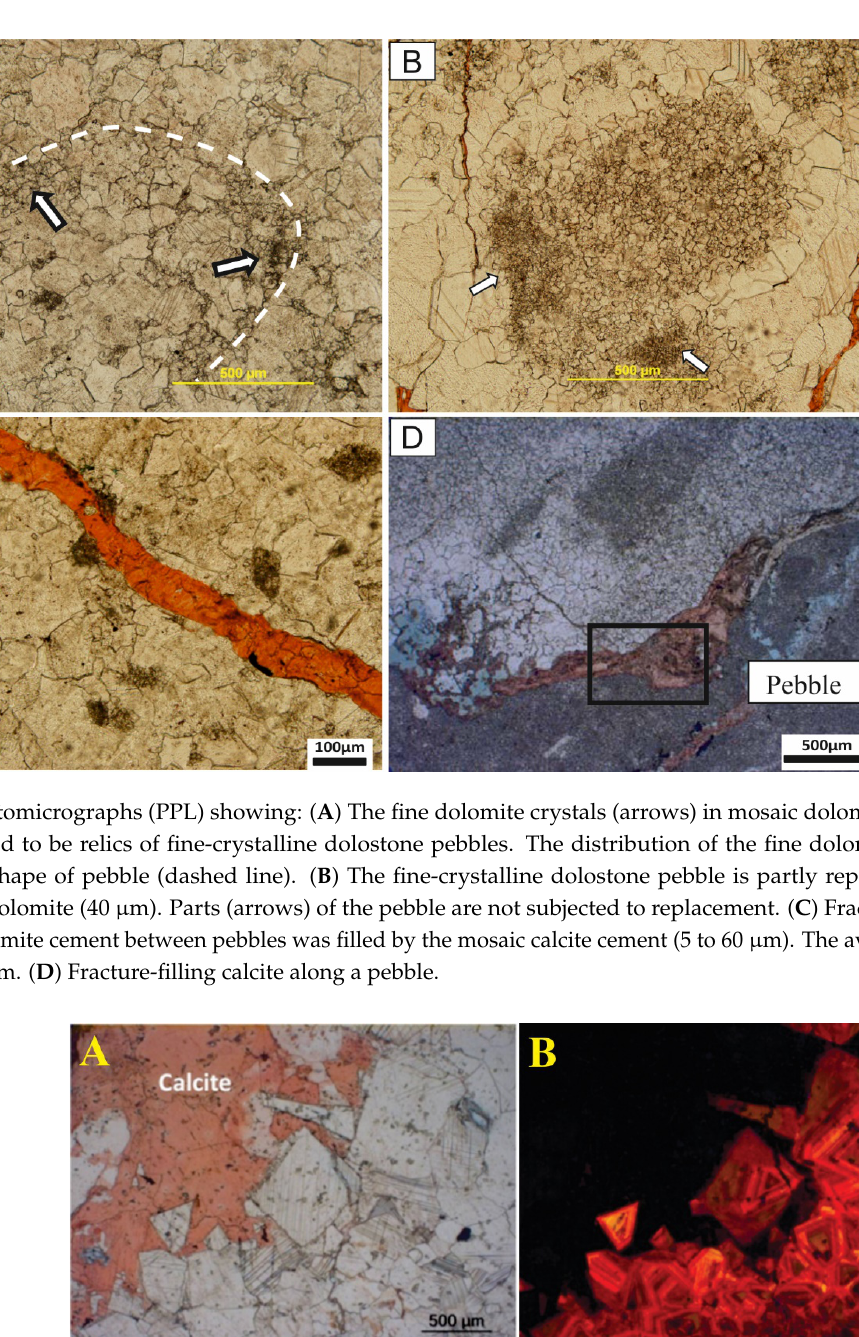
Figure 5. Optical ( A ; PPL) and companion CL ( B ) photomicrographs showing several generations of dolomite cement, which filled intergranular pores between pebbles are characterized by a distinguishable luminescent degree. Optical ( C ; PPL) and companion CL ( D ) photomicrographs showing: Coarse mosaic dolomite cement and coarse calcite cement, which is reddish stained in intergranular pores between pebbles; concentric growth pattern of planar-e to planar-s mosaic dolomite and non-luminescent calcite cements precipitated in pore space, where precursor dolomite was dissolved. Four generations of dolomite cement have been identified in the companion CL ( D ) photomicrograph. Optical ( E ; PPL) and companion CL photomicrographs ( F ) showing the calcite precipitated in intercrystalline pores between pebbles (white arrow) and within stylolite (yellow arrow) is characterized by a non-luminescent zone.